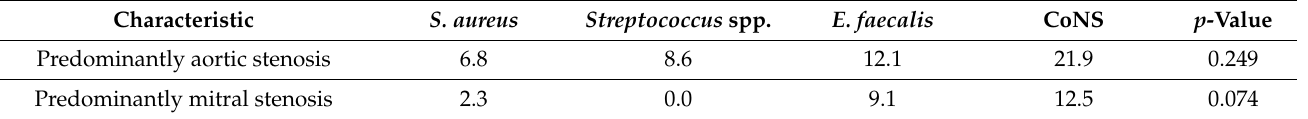
Table note: CoNS—coagulase-negative staphylococci; ICU—intensive care unit; CNS—central nervous system. p -Values <0.05 highlighted in bold. In the CoNS group, the highest incidence of prosthetic valve endocarditis and perivalvu- lar complications were observed. Patients with CoNS caused IE presented with higher BMI when compared to patients with endocarditis caused by other bacterial agents (26.8 vs. 24.6 kg/m 2 , p = 0.003), however, no significant association with type 2 diabetes was found